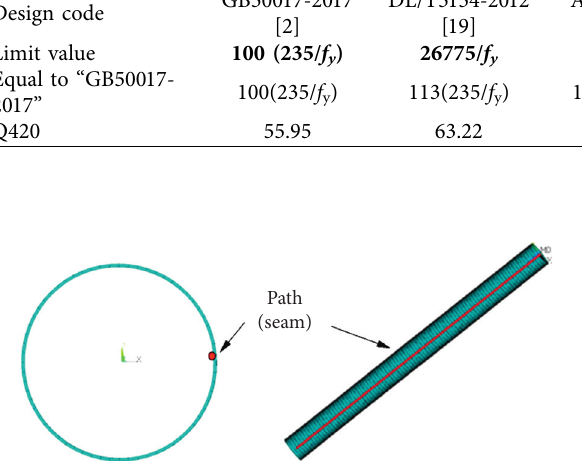
Figure 14: Mapping path of FEA results.